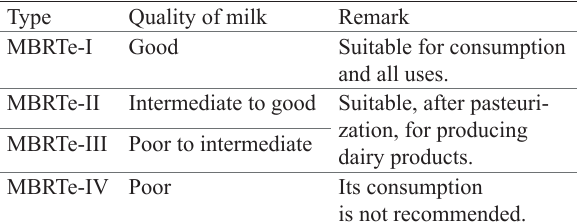
Table 2 MBRTe types and the quality of fresh milk Type Quality of milk Remark MBRTe-I Good Suitable for consumption and all uses. MBRTe-II Intermediate to good Suitable, after pasteuri- zation, for producing MBRTe-IV Poor Its consumption is not